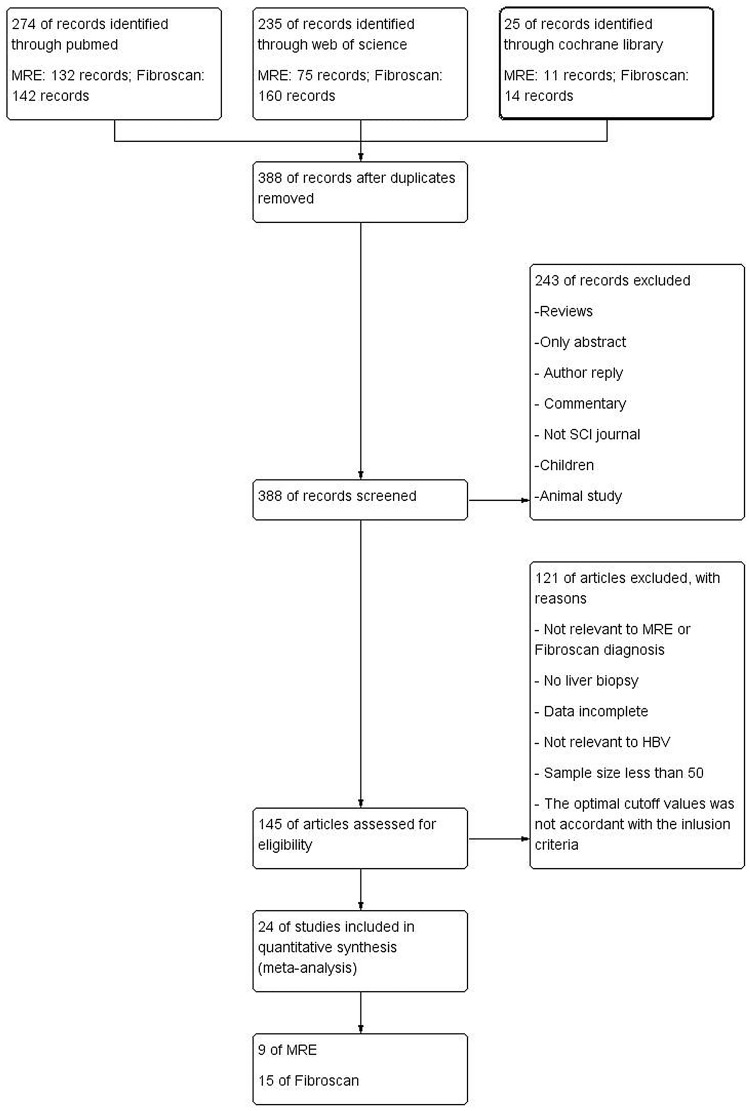
The study flow diagram.Published studies were identified to assess the accuracy of MRE and Fibroscan for diagnosing liver fibrosis.